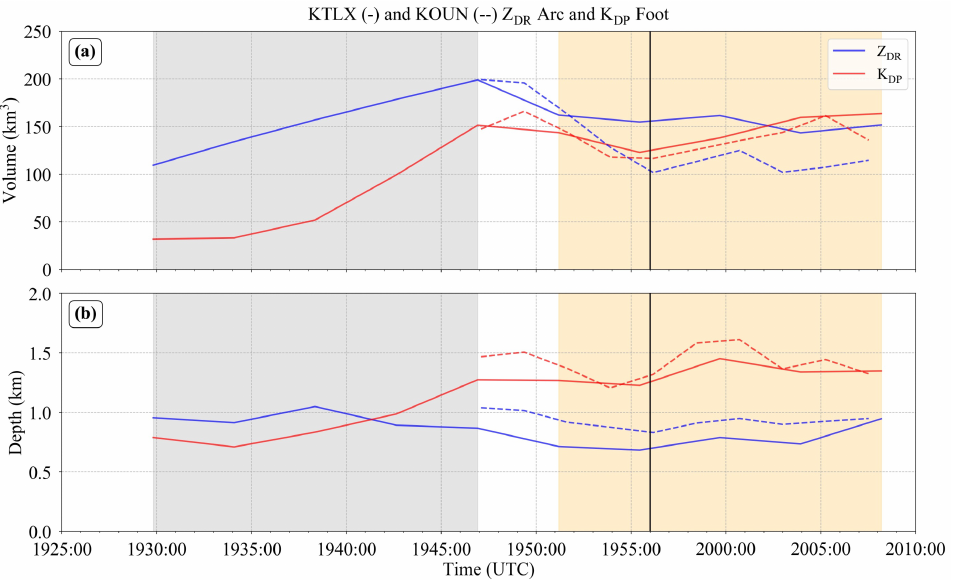
Figure 11. Using KTLX (solid lines) and KOUN (dashed lines): Time series of Z DR arc and specific differential phase ( K DP ) foot ( a ) volumetric extent of the enhancement regions and ( b ) 90th percentile of the depth of the enhancement regions. The gray and orange shaded regions mark the first and second period, respectively, with the solid black vertical line denoting the time of